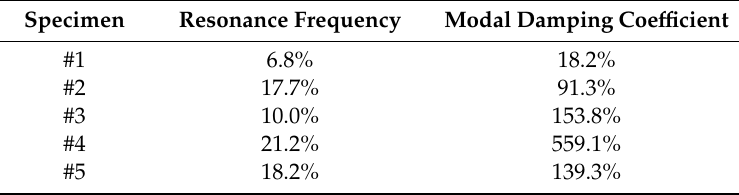
Table 5. Maximum relative error over the result in a condition of − 15 ◦